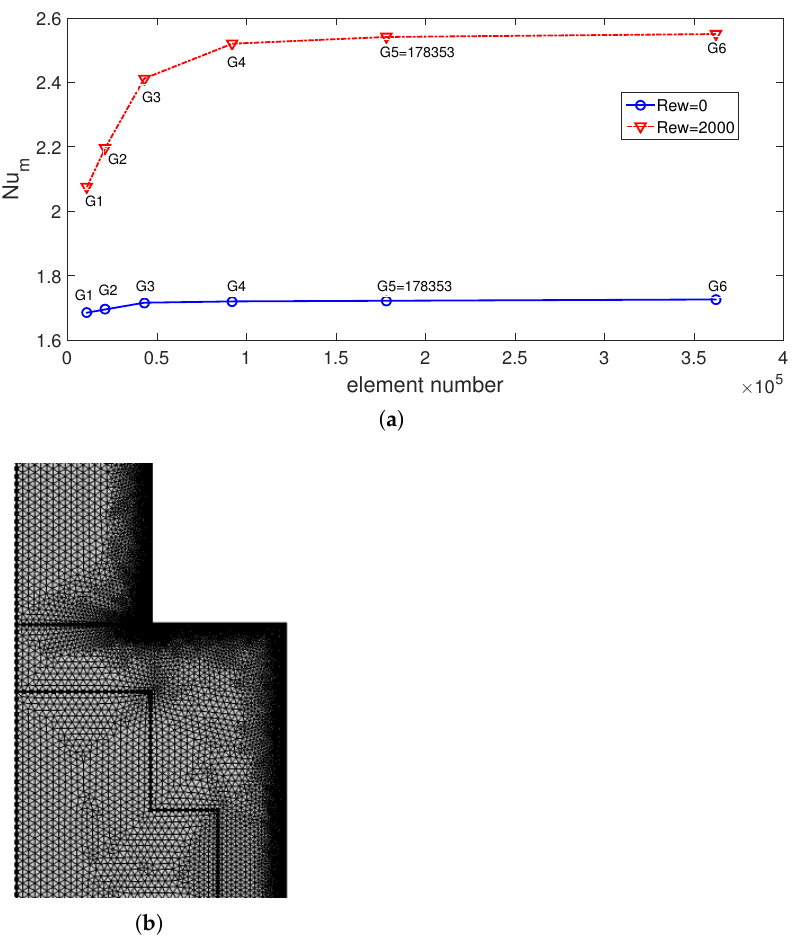
Figure 2. Numerical test results for grid independence at two Rew ( a ) (Re = 250, Da = 10 − 1 , Ha = 7.5, ax = 0.25 ap, N = 4) and distribution of grid ( b